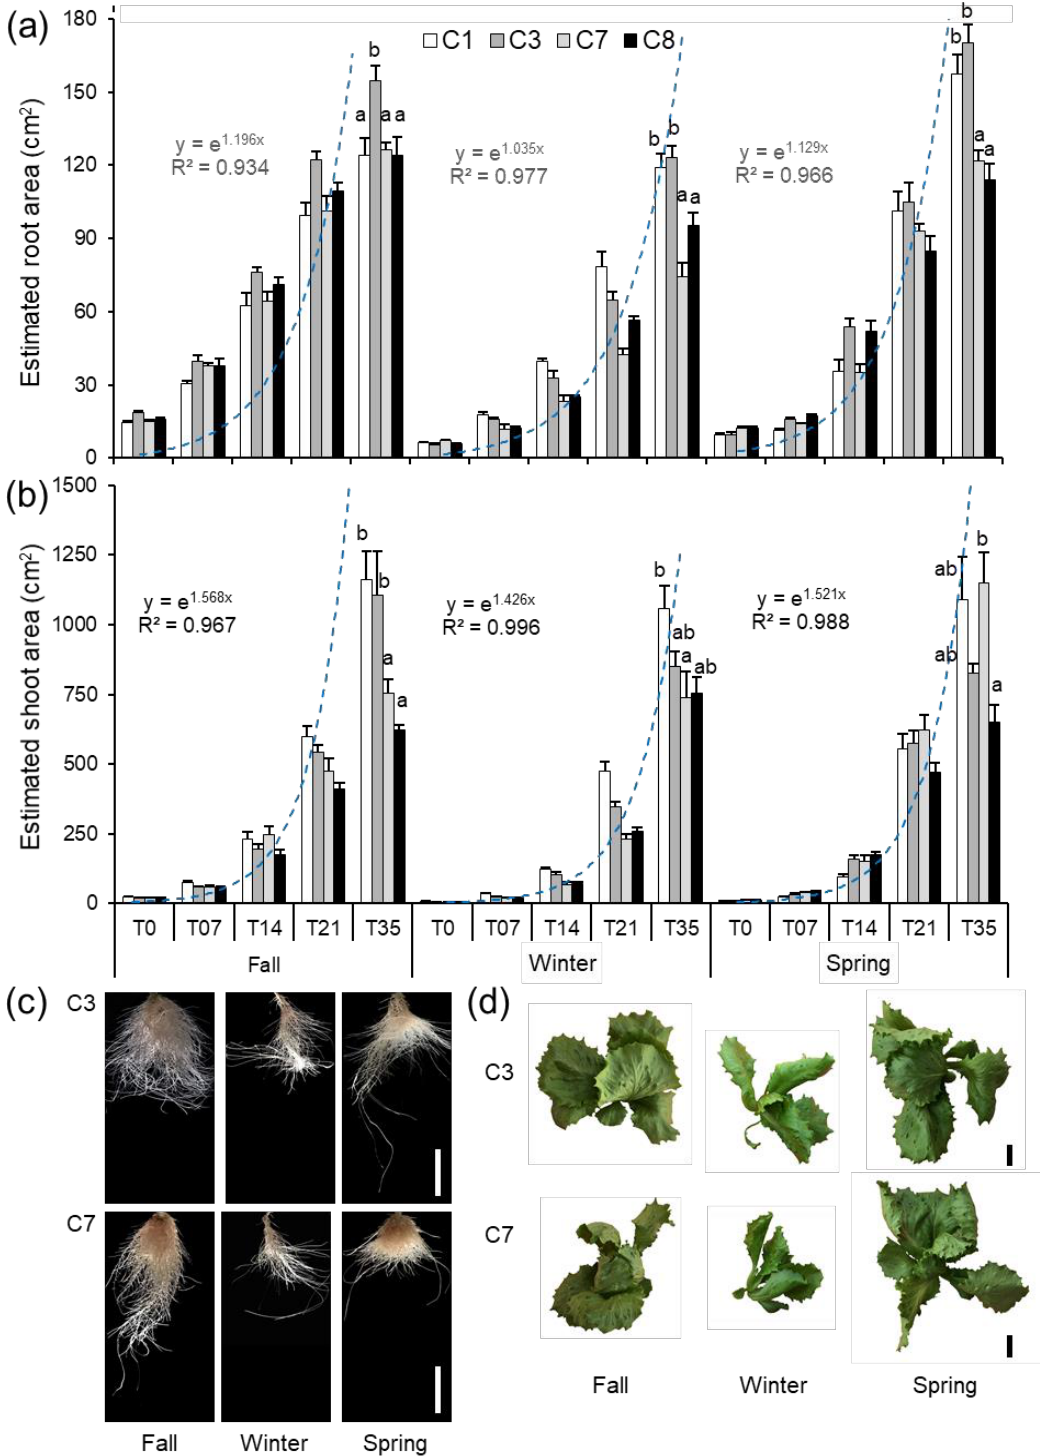
Figure 2. Quantitative analysis of root and shoot area in the studied CHD genotypes during hydroponic growth. ( a ) Average root area (cm 2 ) and ( b ) average shoot area (cm 2 ) values in the studied lines (C1, C3, C7, and C8) between 0 (T0) and 35 (T35) days after planting (dap). Theoretical exponential growth curves are depicted in blue. Different letters indicate significant differences at 35 dap (LSD; p -value < 0.01). ( c , d ) Representative images of the root ( c ) and shoot ( d ) system of C3 and C7 genotypes at 14 and 21 dap, respectively. Scale bars: 50